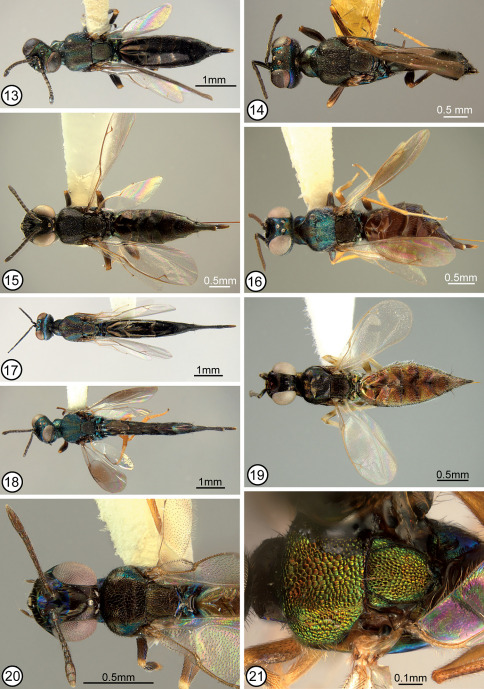
13−19 dorsal ♀ habitus: 13 Calosota aestivalis (20) 14 Calosota kentra (holotype) 15 Calosota longivena (holotype) 16 Calosota bicolorata (holotype) 17 Calosota elongata (24) 18 Calosota longiventris (40) 19 Calosota albipalpus (8) 20 Calosota speculifrons ♀, head and dorsal mesosoma (5) 21 Calosota panamaensis ♀, dorsal mesosoma (holotype). Numbers in parentheses = CNC Photo 2009-no.